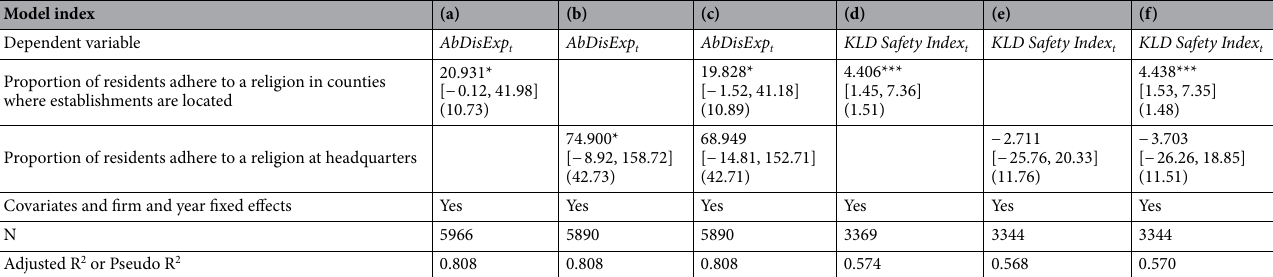
Table 5. The relationship between the degree of local religiosity on overall firm level workplace safety investment. Columns (a)–(c) displays statistics from OLS models that regressed each enterprise’s abnormal discretionary expenses per employee 44 on, respectively, its weighted average value of the religiosities of the counties where the enterprise’s establishments are located, weighted by the number of employees in each establishment (a) and the proportion of residents acknowledging a religious affiliation in county where its enterprise’s headquarter is located (b) and both religiosity measures (c) 30,33,34 . A set of covariates and firm and year fixed effects are included in all models. Columns (d)–(f) report ordered logit regressions of the safety index—constructed using the “MSCI ESG KLD STATS” data set from MSCI ESG Research—on those same variables. All coefficient estimates and associated statistics appear in the supplementary information, but we display the estimate for the focal coefficients—weighted average establishment religiosity and headquarter religiosity—in the third and fourth row of the table, respectively, following the model index and the listing of the dependent variable used in each model. The fifth row indicates whether the model involved covariates and binary indicators signaling the firm and year of a given record for an enterprise. The second to last row lists the number of observations (N) and the final row displays the proportion of explained variance (R 2 ), adjusted for covariates. Asterisks denote the level of p values: *** p < 0.01, ** p < 0.05, * p < 0.10.